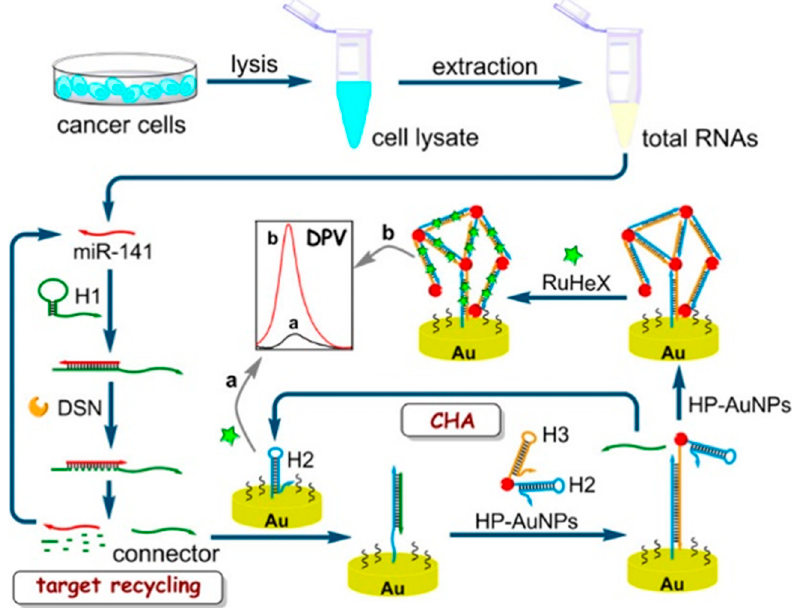
Figure 2. Schematic representation of cascade amplification of DSN-assisted target recycling and CHA reaction and in situ self-assembly of AuNP networks on electrodes for label-free electrochemical detection of miR-141 in signal-on mode [39]. Copyright 2018 American Chemical Society.